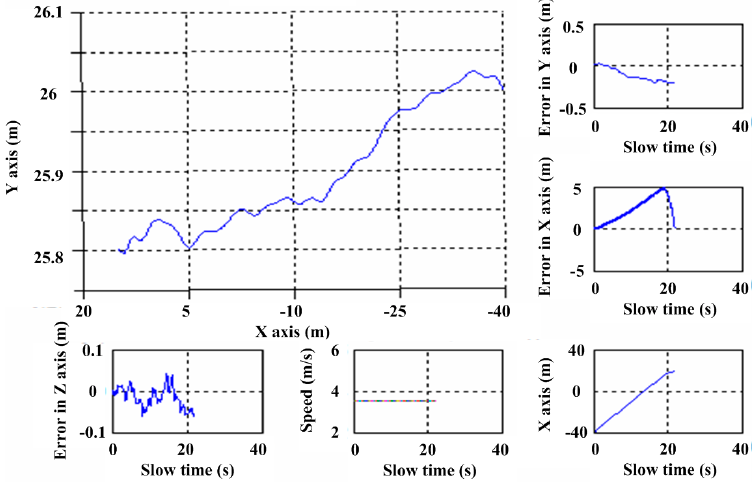
Figure 16. Position of the vehicle-based radar from the GPS data.